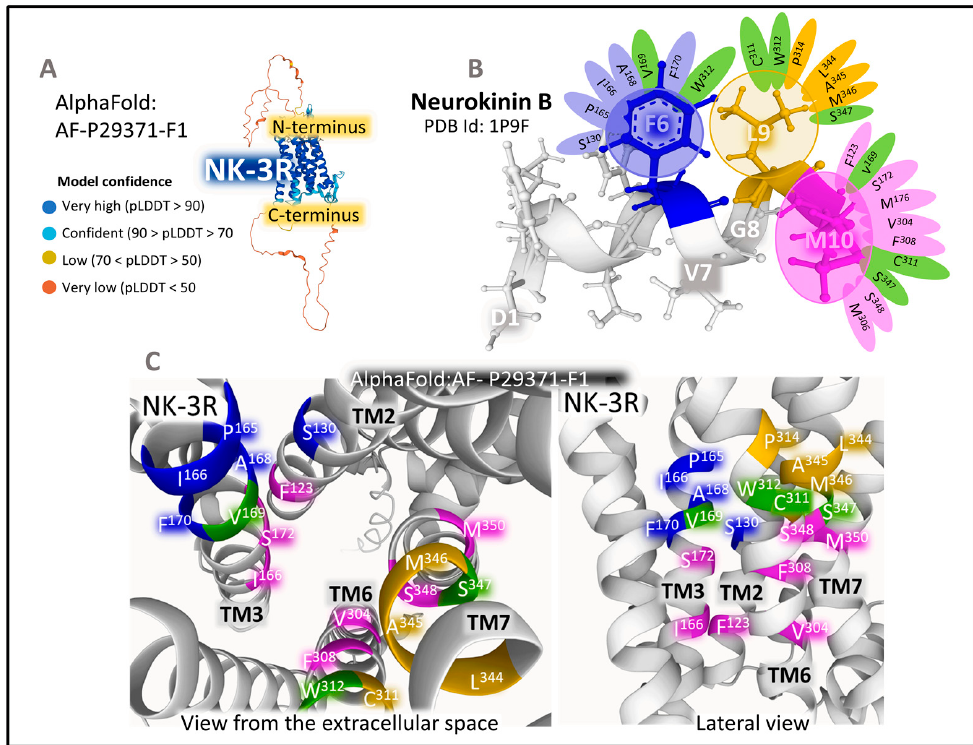
Figure 5. ( A ) represents the predicted structure of NK-2R (UNIPROT P29371) [25] according to the prediction Alpha-Fold model [62–64]. The parameter pLDDT (predicted local distance difference test) assessed the model confidence. ( B ) depicts the 3D structure of NKB determined by NMR obtained from the Protein Data Bank [65] (PDB ID 1P9F, [67]) and drawn with Mol* free web-based software [71]. The panel also shows the contacts of NKB’s C-terminal amino acids with the receptors’ amino acids. ( C ) illustrates two views of a three-dimensional representation of NK-2R, obtained from modeling and docking studies [56], indicating the principal amino-acid positions in the Alpha-Fold model of NK-2R closely contacting the C-terminal region of NKA. Residues in green contact more than one pharmacophore of